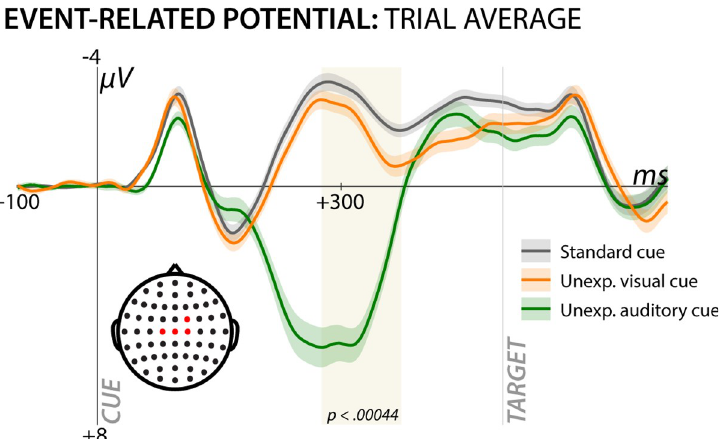
Fig 5. Average channel event-related response to the three different cue types, plotted at the channels in which the winning model (separate surprise terms; Model 1) provided significantly better fit than the losing model (common surprise term). Beige highlighting denotes the time window in which the winning model significantly fit the single-trial EEG response. This trial average illustrates that the time window in which the fit was significant contains the fronto-central P3 ERP to both unexpected auditory and visual cues. Shaded area around the ERP curves denotes the standard error of the mean.